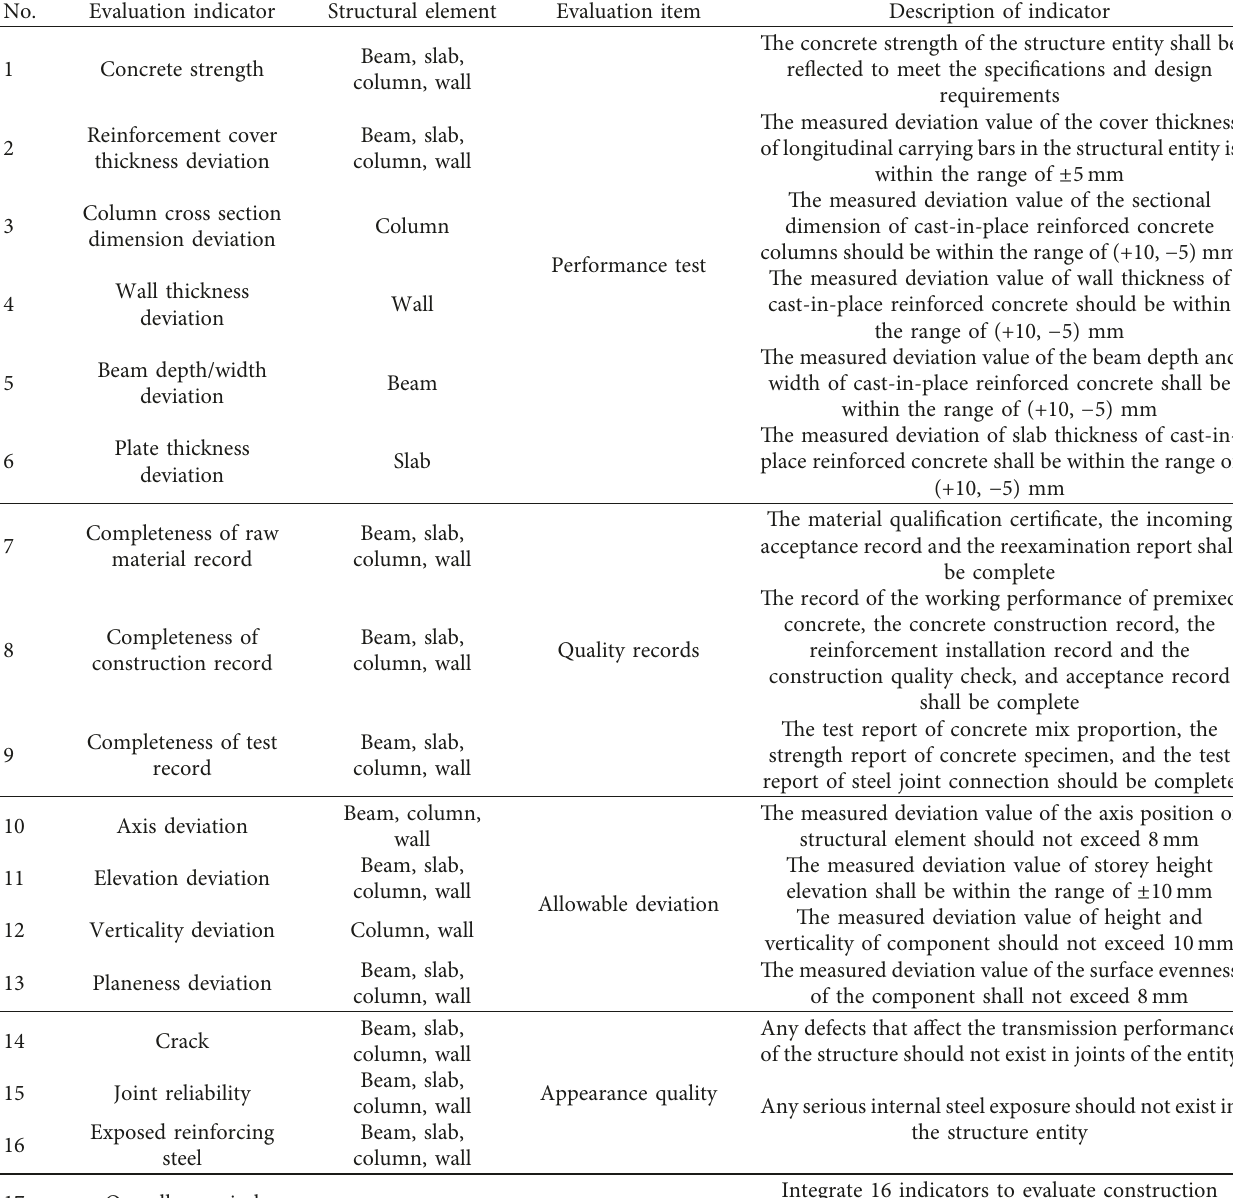
Table 1: Evaluation index for construction quality of reinforced concrete main